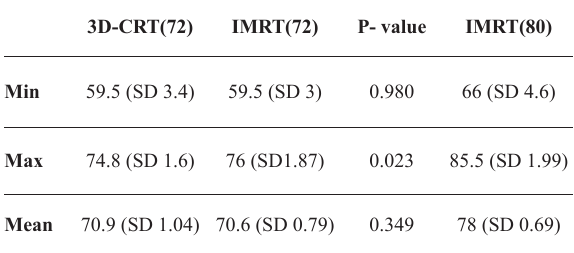
Figure 1: Axial IMRT planning slice of a patient in the study Table 1: Mean PTV minimum and maximum values of IMRT and 3D-CRT